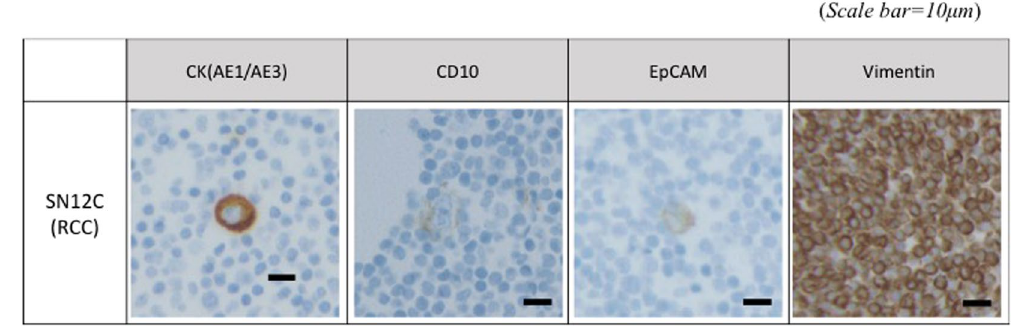
Figure 6. The immunocytochemical stain in RCC cell line (SN12C) cell block (Scale bar = 10 μ